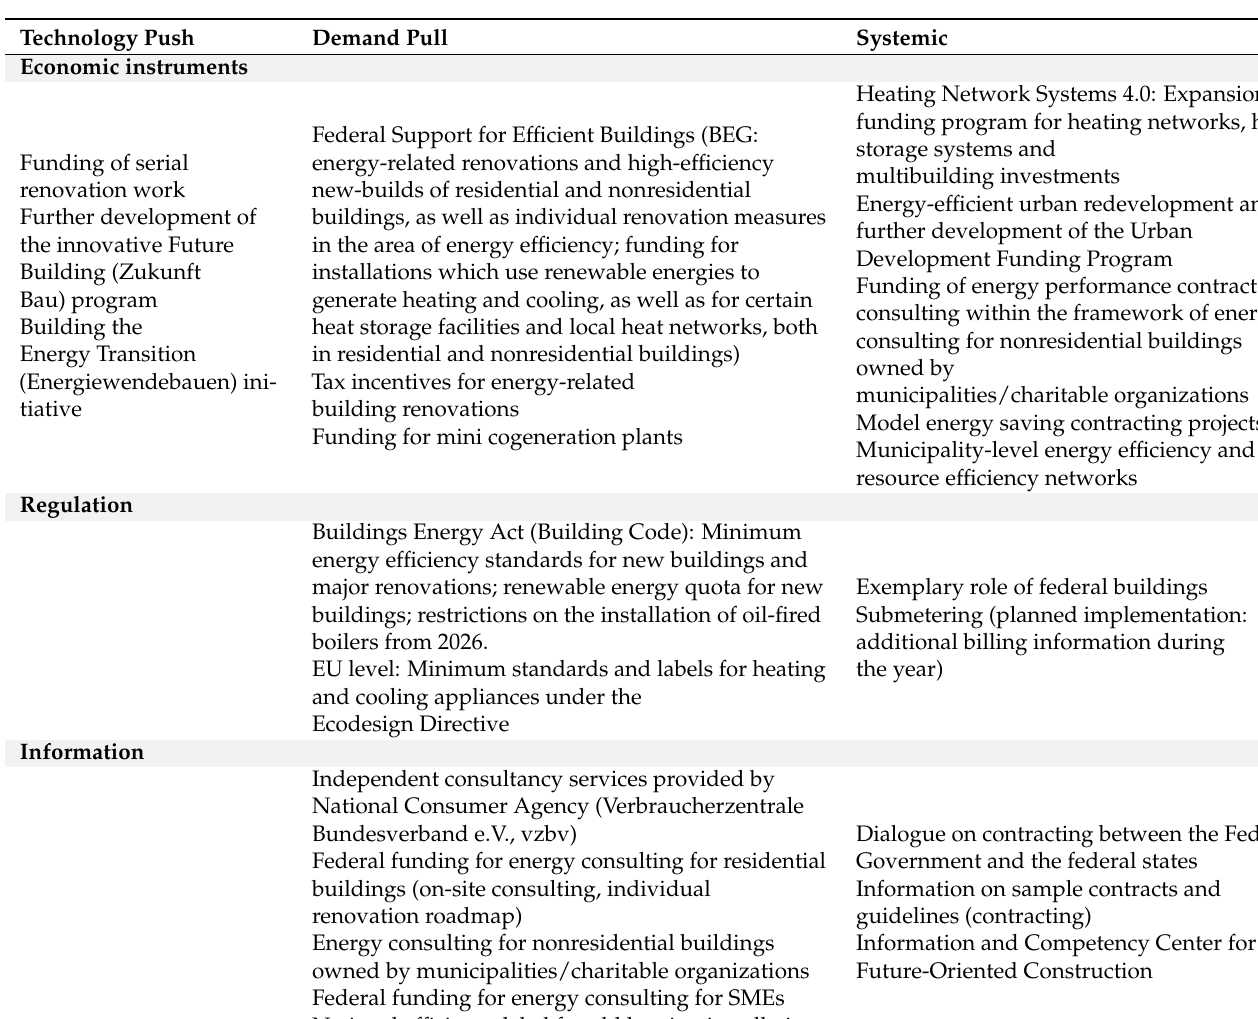
Table 2. Policies addressing the transition of the buildings sector in